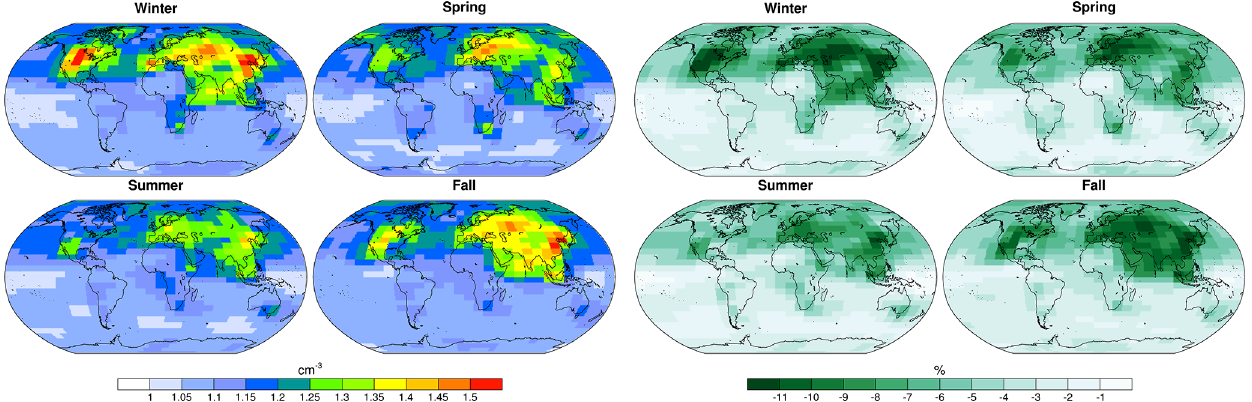
Figure A4. Seasonal CDNC factor increases (left frame) and associated droplet radius reductions in percent (right frame) due to today’s anthropogenic aerosol and the preindustrial fine-mode background as defined by MACv2.